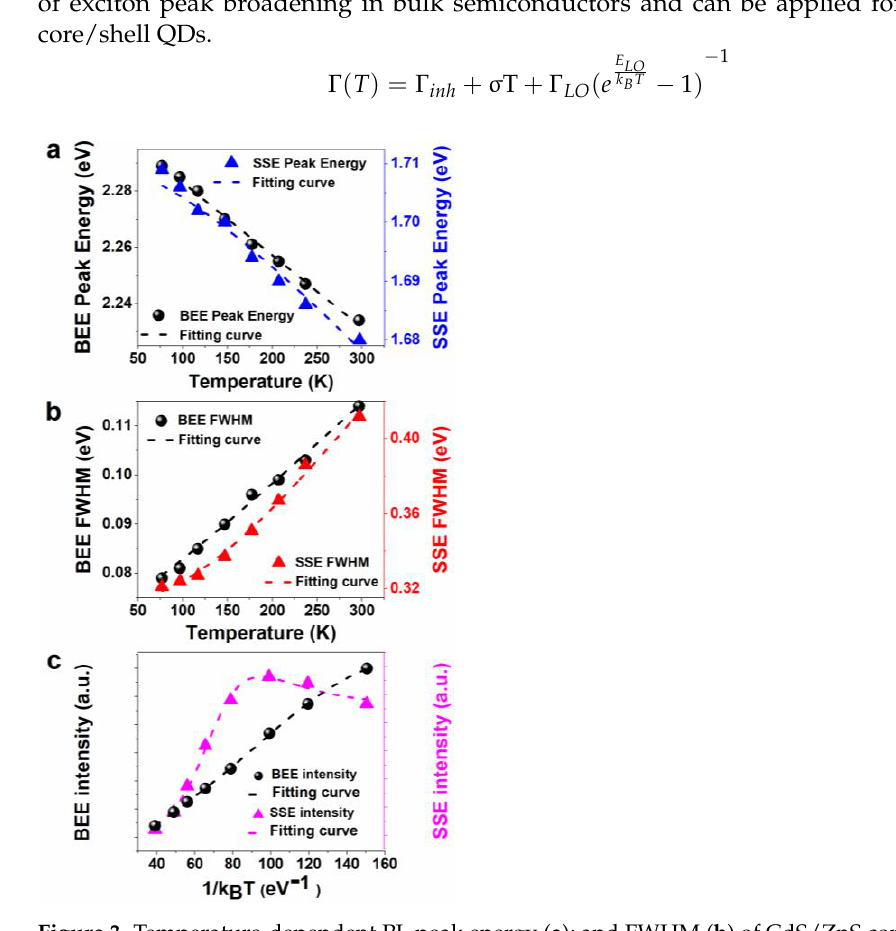
Figure 3. Temperature-dependent PL peak energy ( a ); and FWHM ( b ) of CdS/ZnS core/shell QDs in a temperature range of 77 – 297 K, respectively. Short dotted lines represent the fitting curves; ( c ) PL intensities of CdS/ZnS core/shell QDs as a function of inverse k B T in a temperature range of 77–297 K. In the figure, spheres represent BEE peak energy, BEE FWHM and BEE intensity; triangles represent SSE peak energy, SSE FWHM and SSE